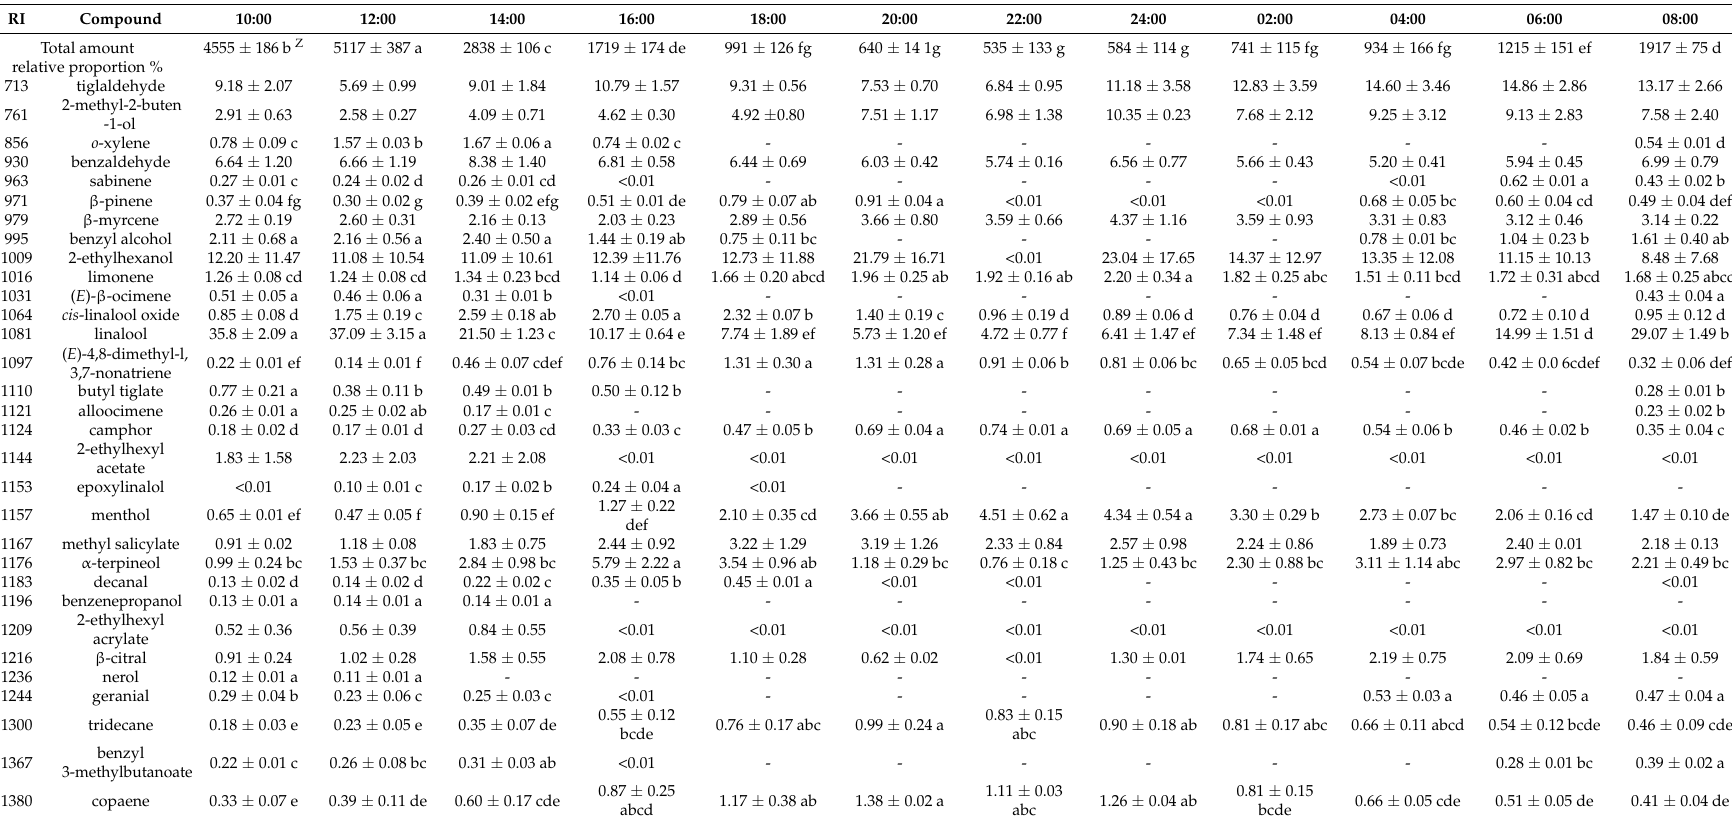
Table 2. Total volatile components and relative proportion of single compounds (%) in Onc. Rosy Sunset over a daily